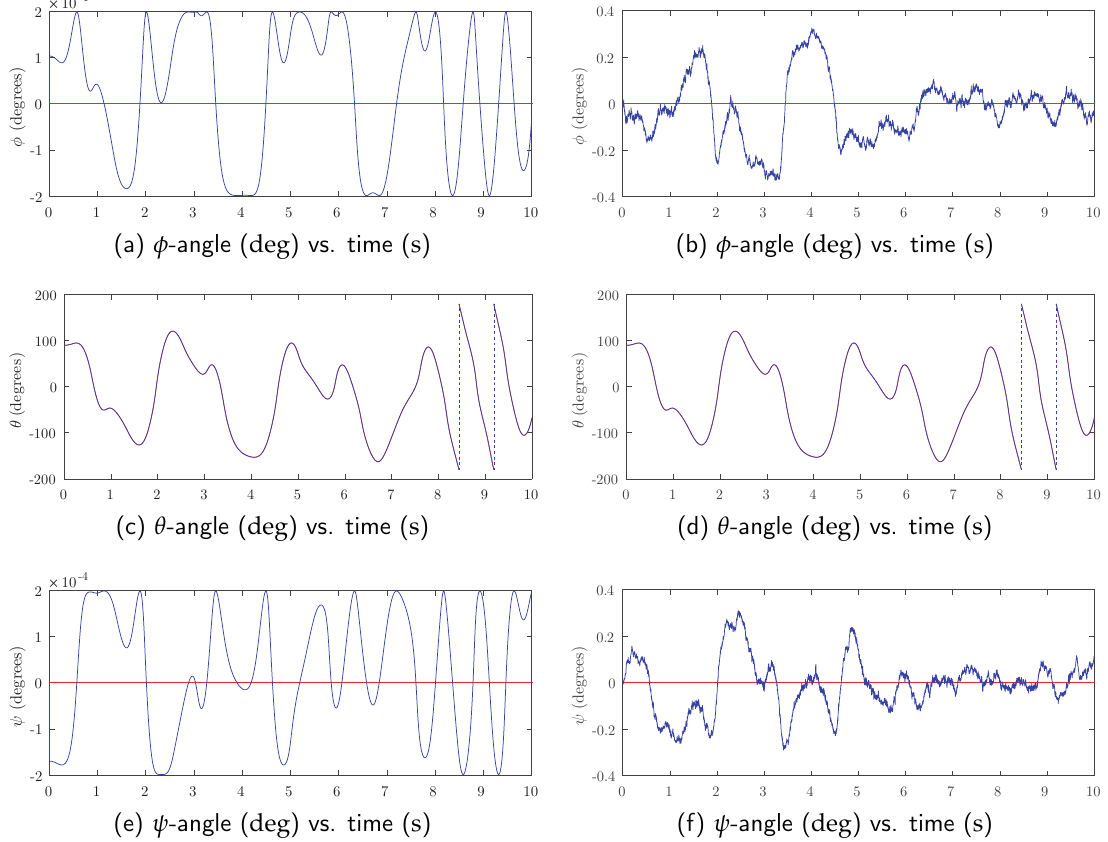
Figure 3. Simulation of the dynamics of the double pendulum on the xz-plane: Euler parameters calculated by numerical integration (red line) and estimated using the proposed filter when virtual sensor data have no noise (left) and when they have noise